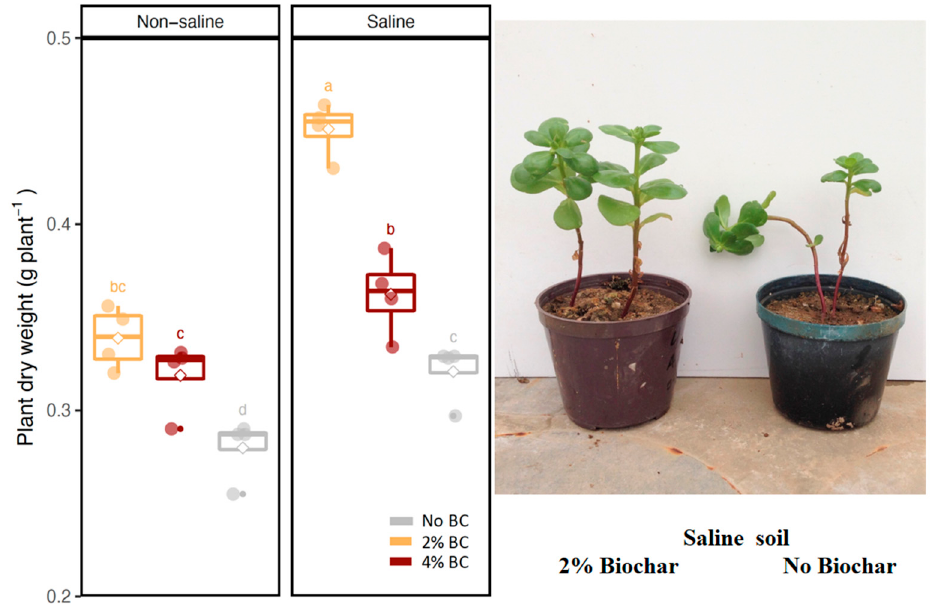
Figure 1. Effect of biochar application (2% BC, 4% BC) on dry weights of purslane biomass growing under saline or non-saline conditions. BC: biochar. Letters within each column are significantly different based on Duncan’s test. The top and bottom of the box represent 75% and 25% quantiles, respectively. The bars of the box represent maximum and minimum values of observations. The line in the box represents the median. The dots represent every single observation. The rhombus in the box represents the mean. Table 1. Main effect and two-way interactions of biochar and salinity on plant dry weight,